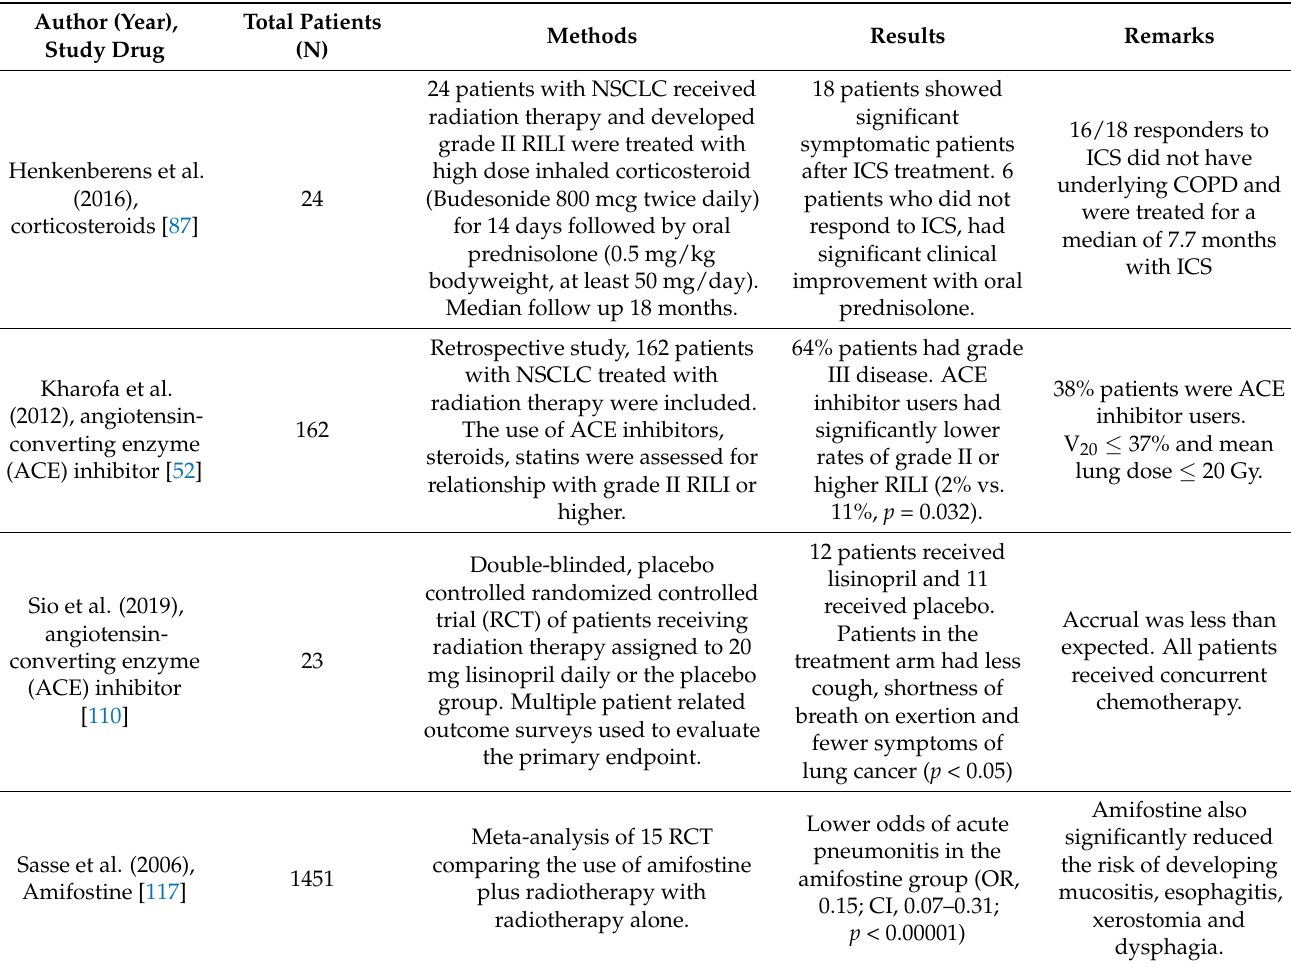
Table 4. Important studies evaluating various therapeutic options for radiation-induced lung